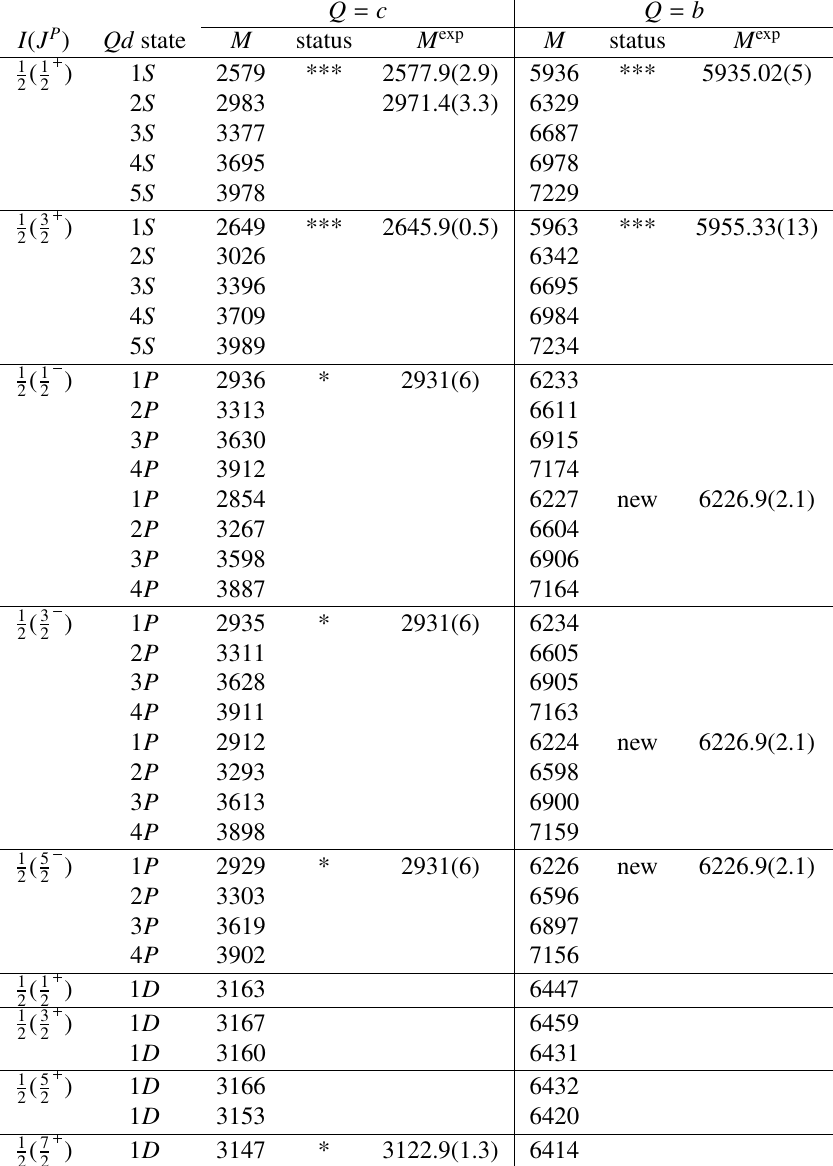
Table 4. Masses of the Ξ Q ( Q = c , b ) heavy baryons with the axial vector diquark (in MeV) Q = c Q =